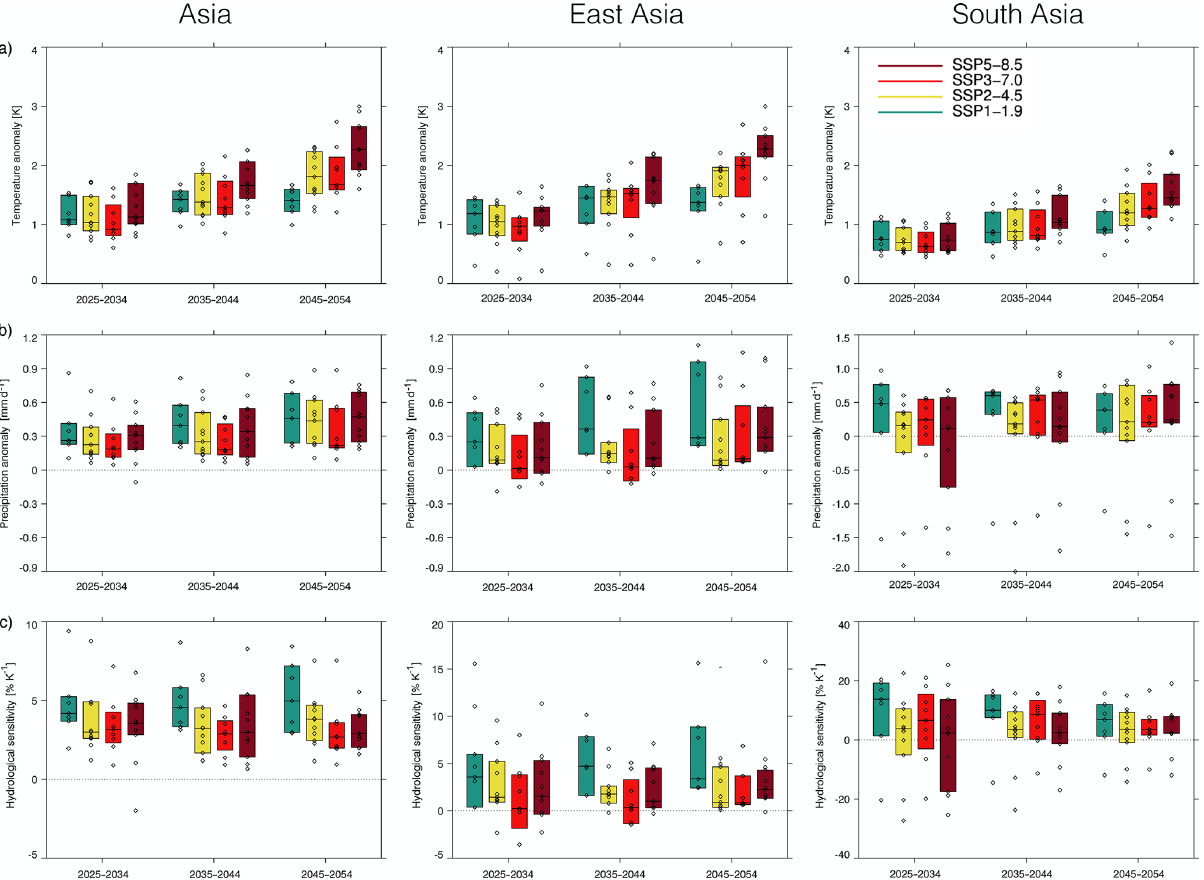
Figure 8. Regional-mean JJA-mean (a) temperature (K), (b) precipitation (mmd − 1 ), and (c) hydrological sensitivity (%K − 1 ) anomalies relative to 1980–2014 for Asia, East Asia, and South Asia. The three regions are indicated by the boxes in Fig. 6. Coloured bars show the interquartile range, and the horizontal bar within this shows the median. Diamonds show values from each model listed in Table 1 as having data availability for a given SSP. Where multiple ensemble members are available, the model mean is used. Note that different y ranges are used for each region in (b) and (c)